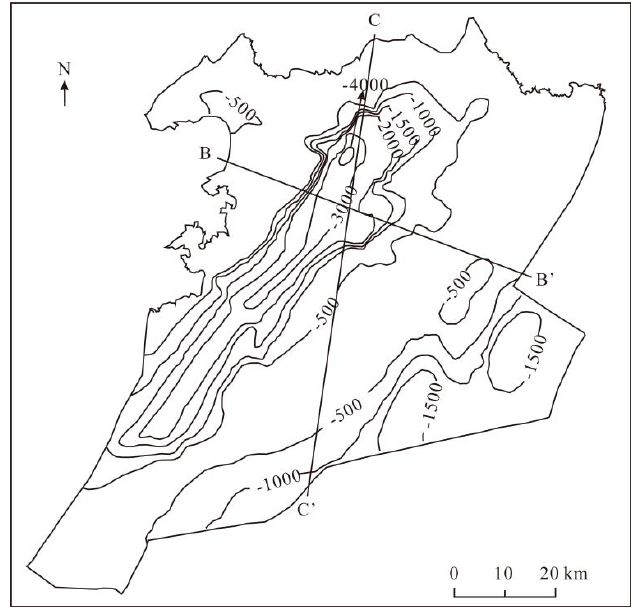
Figure 7. Contour of the elevation of the geothermal reservoir roof.